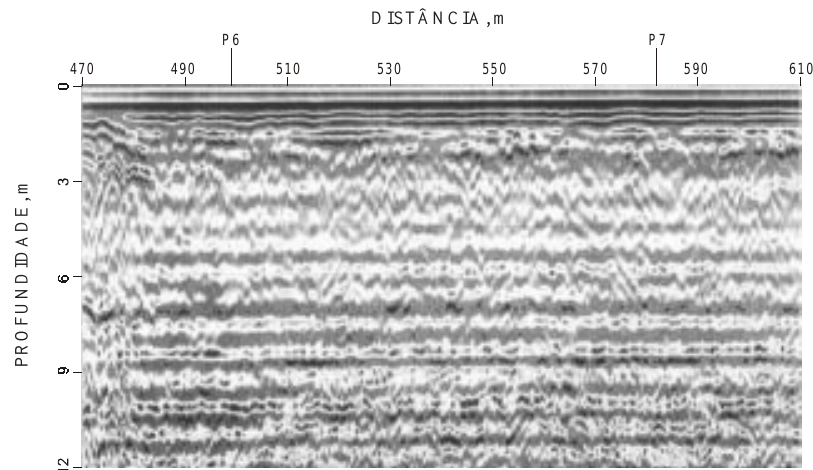
Figura 5. Radargrama - R4 mostrando o final do domínio do Argissolo Acinzentado (470-478 m) passando para o domínio do Latossolo Amarelo. Os perfis P6 e P7 estão localizados nas distâncias de 449 e 582 m, respectivamente.